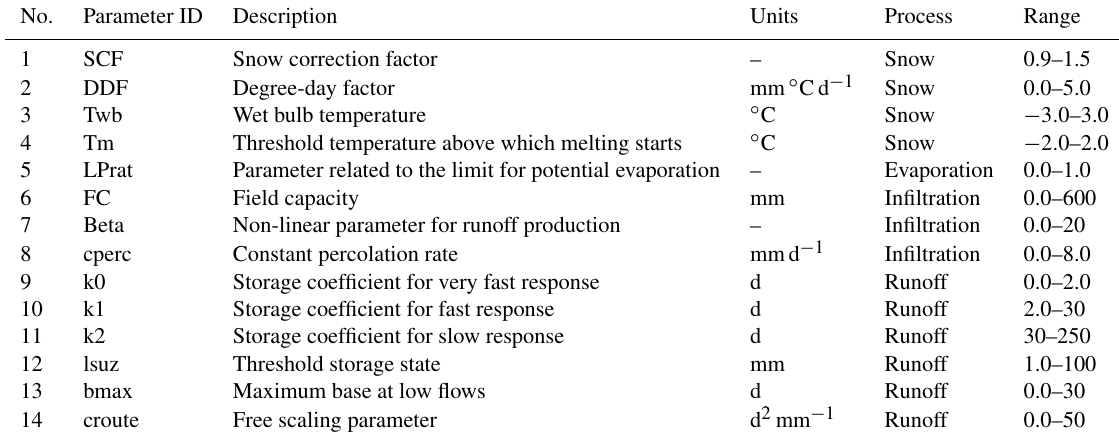
Figure 2. Comparison of P products over 1990–2018 (full time period): (a) mean annual P for each product resampled to a 0.05 ◦ spatial resolution using the nearest neighbour method. The dark red horizontal lines represent the limits of each major macroclimatic zone and (b) mean monthly P averaged over each catchment located within each macroclimatic zone (see Fig. 1d). Table 3. Summary of the TUWmodel parameters considered for calibration, following the conceptualisation presented in Széles et al. (2020).